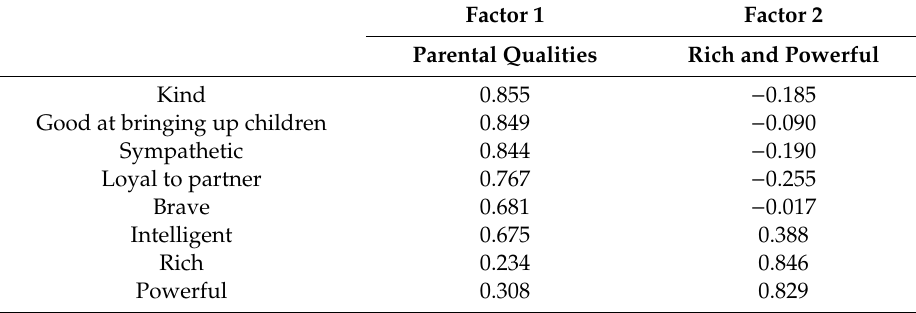
Table 1. Factor loadings of associated with good parental skills .